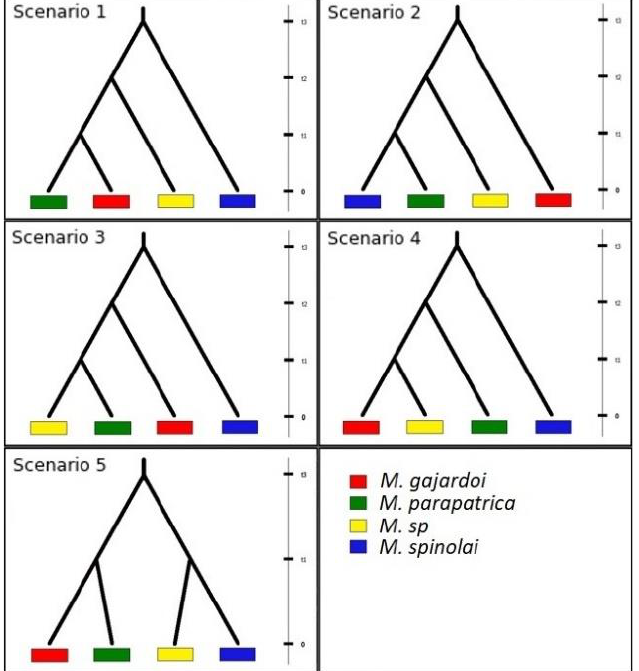
Figure 2. Phylogeographic hypotheses tested in this study. Scenario 1: hypothesis generated by the BMCMC proposed colonization from the Coquimban Biogeographical Province (Figure 1a) to the north, where the most southerly species M. spinolai is sister to the northern clade formed by M. gajardoi , M. parapatrica and M. sp, and, within this clade, M. sp. is sister to the remaining species M. gajardoi and M. parapatrica [9]. Scenario 2 represents the colonization hypothesis from north to south proposed by Frias-Lasserre (2010) [8]. Scenario 3: M. spinolai is sister to a northern clade that includes M. gajardoi as sister to the remaining species M. sp. and M. parapatrica . Scenario 4 suggests colonization from south to north following a parapatric speciation model, where M. spinolai is sister to a clade that includes M. parapatrica as sister to the remaining species M. gajardoi and M. sp. Scenario 5 shows a southern clade formed by M. spinolai as sister to M. sp. and a northern clade formed by M. gajardoi and M. parapatrica .